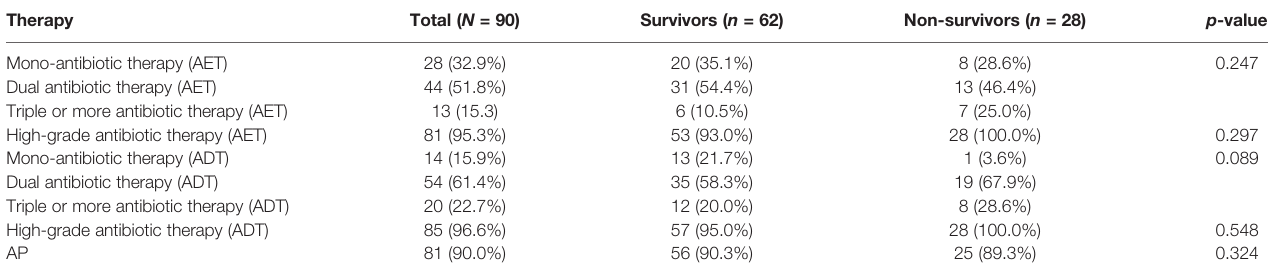
TABLE 4 | Comparison of antibiotic treatments for MDRE-NM patients.